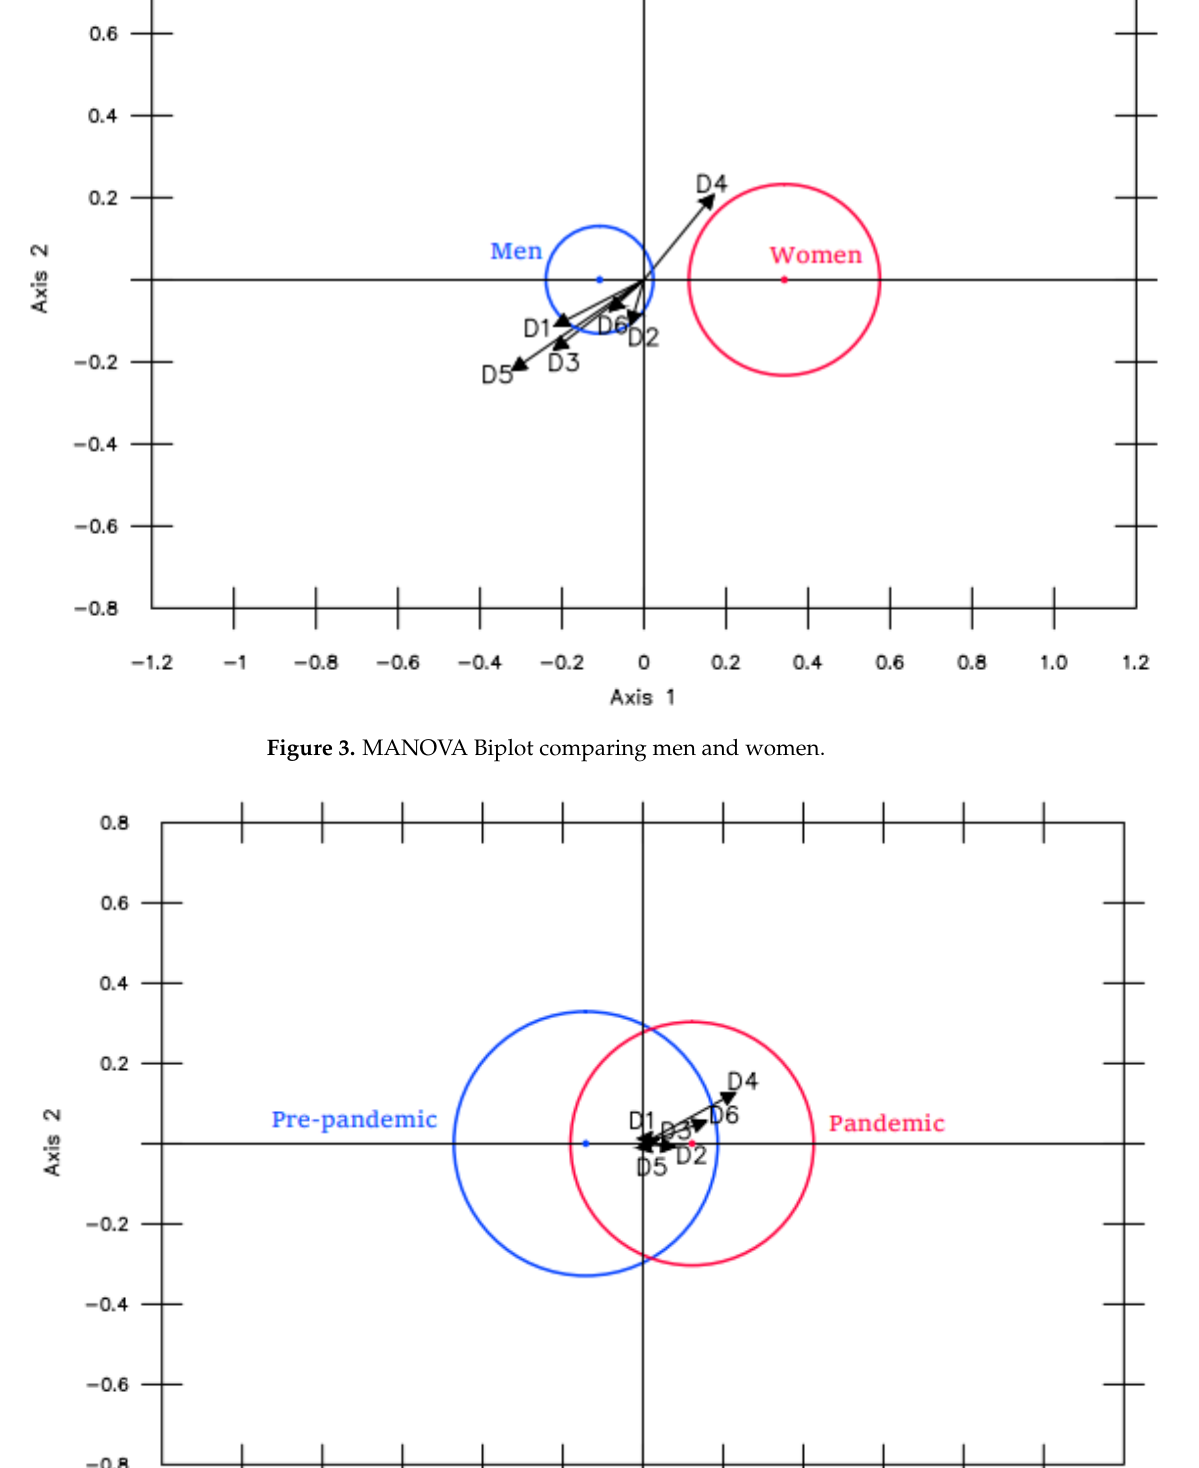
Figure 4. MANOVA Biplot comparing pre- and post-pandemic.